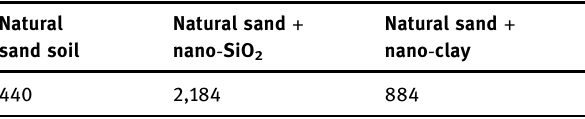
Table 3: Intensity values of di ff erent soils obtained for the quartz peak Natural sand